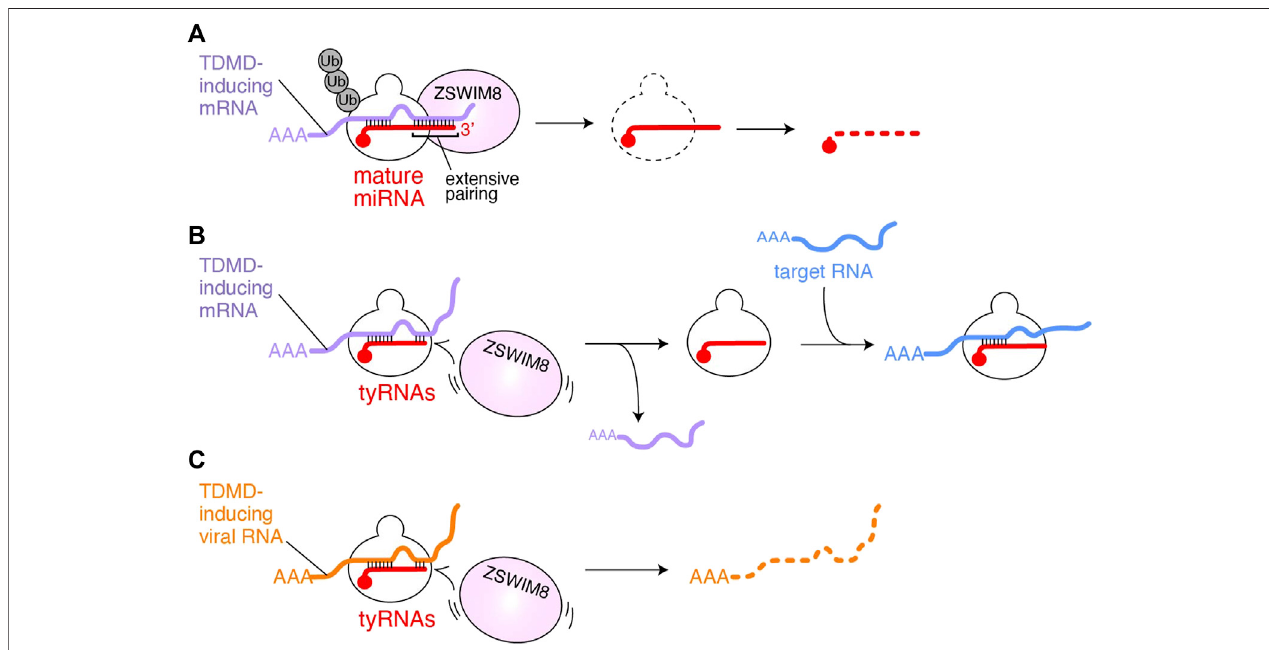
FIGURE 2 | Possible model of tyRNA escaping from TDMD. (A) TDMD-inducing mRNA (purple) is base paired with the seed and 3 ′ region of AGO-associated miRNA (red). The extensive 3 ′ pairing works as a scaffold for ZSWIM8, followed by polyubiquitination of AGO. As a result, the miRNA is exposed to the cellular RNases and degraded. (B) AGO with tyRNAs would fail to recruit ZSWIM8 because it cannot form an extensive pairing with TDMD-inducing mRNAs (purple). Instead, the RISC uses the intact seed to bind to mRNAs (blue) that its full-length mature miRNA targets for gene silencing. (C) AGO with tyRNAs escaping from polyubiquitination may degrade TDMD-inducing viral noncoding RNAs